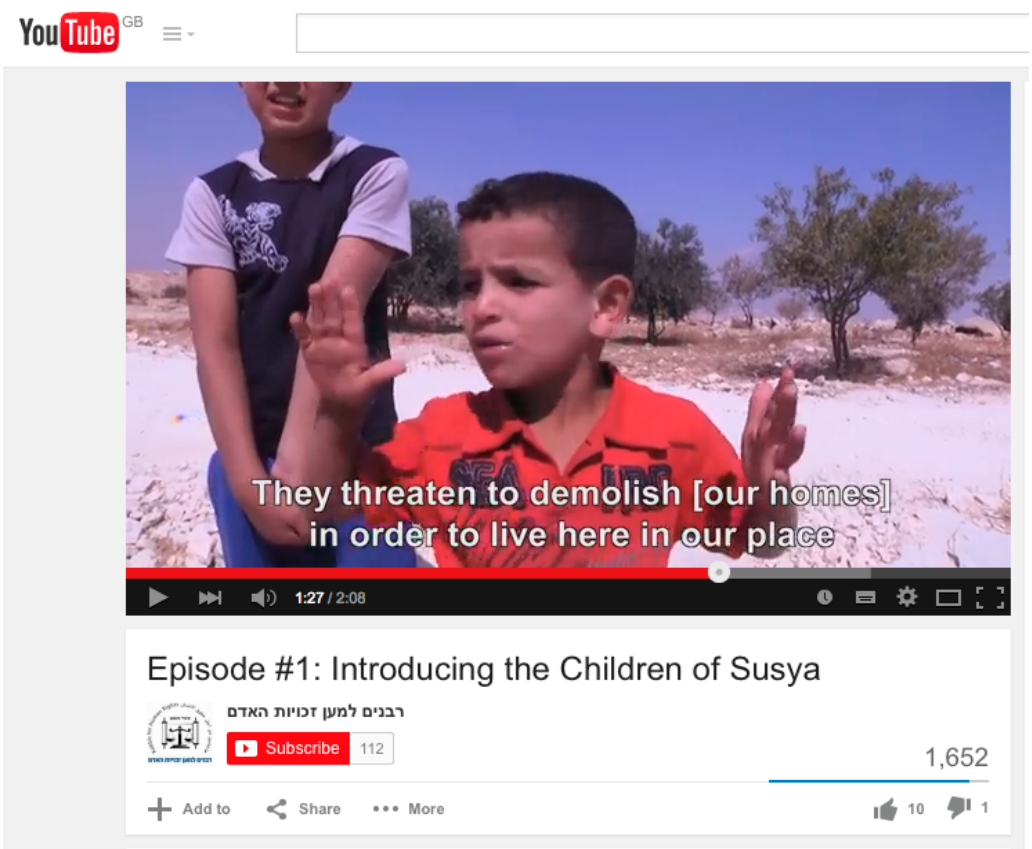
Figure 16. Screen grab from RHR’s YouTube video entitled ‘Introducing the Children of